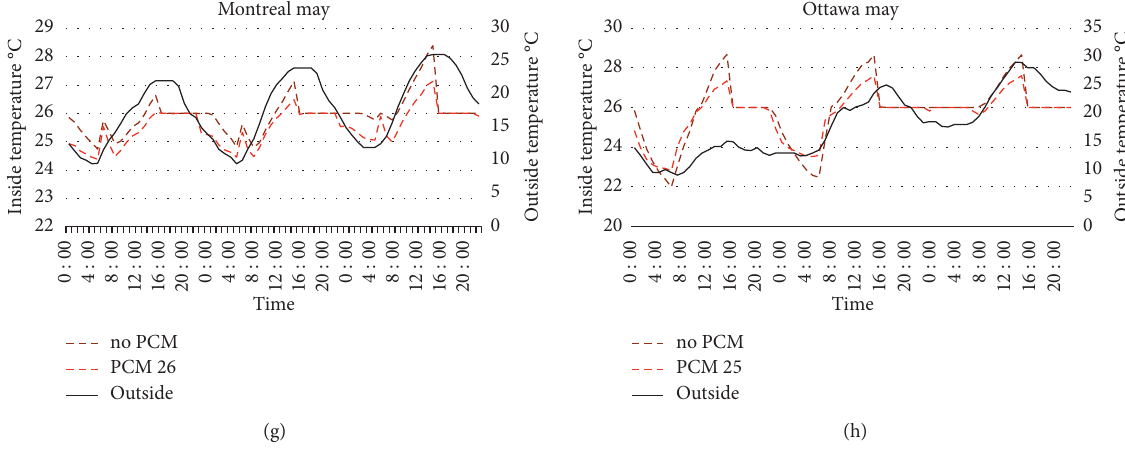
Figure 8: Temperature profiles for all cities for months with the greatest energy savings.